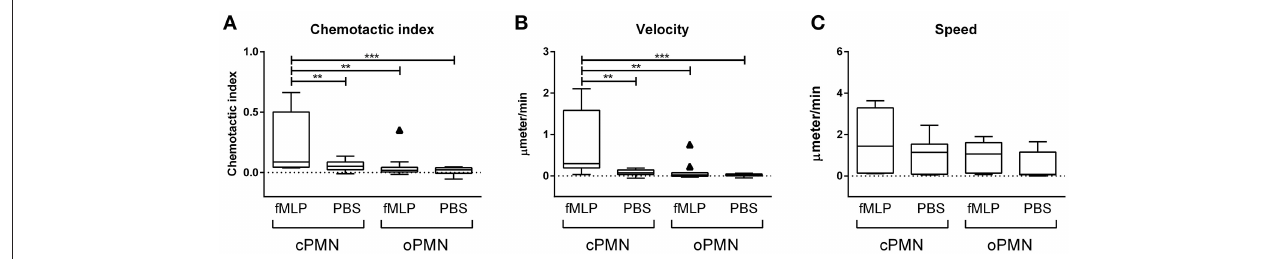
FIGURE 2 | Chemotactic index, velocity, and speed of cPMNs and oPMNs in response to fMLP or PBS. Quantitative analysis of migration is presented in Tukey box and whiskers plots. The box represents the 75 and 25th percentiles with the median presented as a midline. Tukey whiskers represent the minimum and maximum values and outliers were defined as values exceeding 1.5 times the interquartile range. The chemotactic index, which is the directional accuracy of chemotaxis, is presented in (A) . The cell velocity, representing the average speed ( µ meter/min) of the cells moving in its most prominent direction, is presented in (B) . The speed, which is the average speed ( µ meter/ min) moving in any direction is presented in (C) . n = 9, ** p < 0.01, *** p < 0.001.